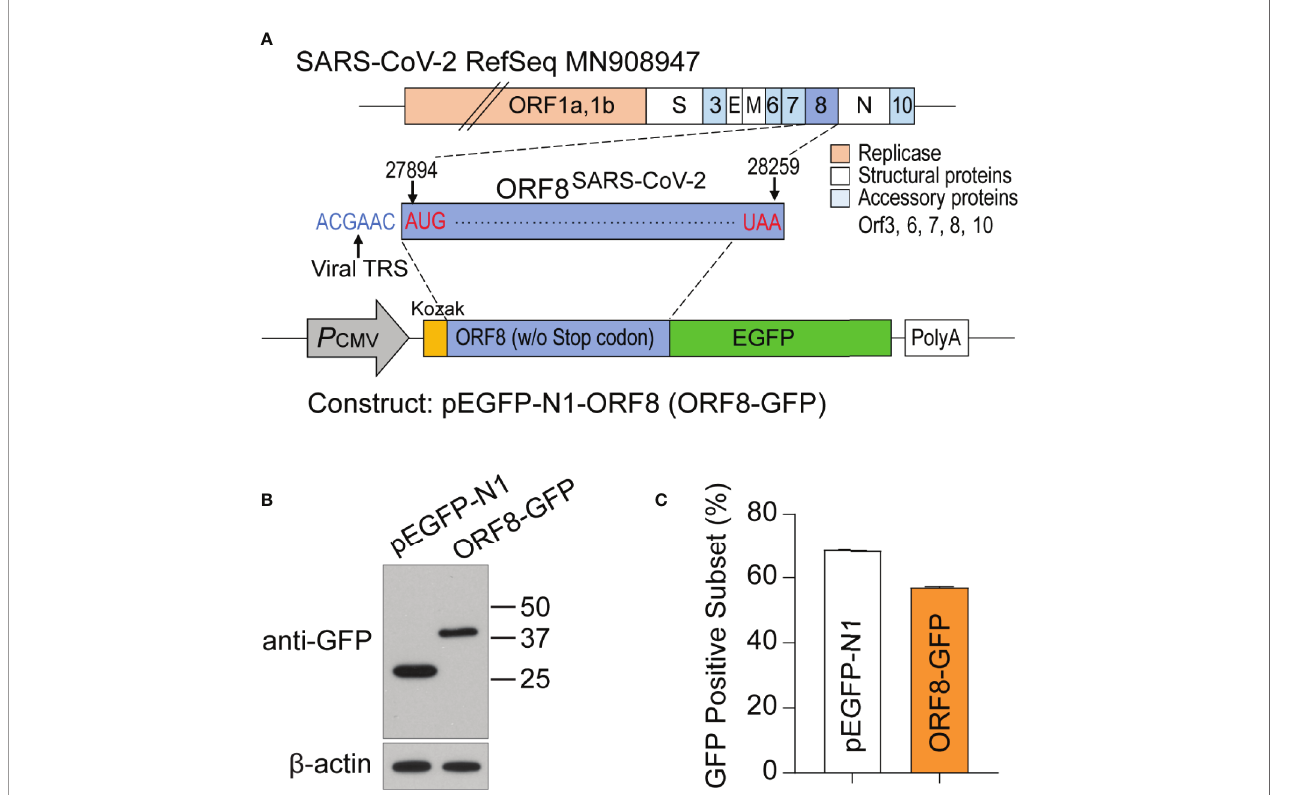
FIGURE 1 | Generating a plasmid construct to study the function of ORF8 SARS-CoV-2 in human A549 lung epithelial cells. (A) Cloning strategy to generate the pEGFP-ORF8 SARS-CoV-2 (ORF8-GFP) construct. (B) Veri fi cation of ORF8-GFP expression in A549 lung epithelial cells transfected with pEGFP-ORF8 SARS-CoV-2 by immunoblot analysis using anti-GFP antibody. Whole cell lysates were collected from cells transfected with empty vector (pEGFP-N1; EV) or ORF8-GFP at 24 hours post-transfection. (C) Characterization of the transfection ef fi ciency of ORF8-GFP in A549 lung epithelial cells using FACS analysis. Cells were subjected to fl ow cytometry 24 hours after transfection with pEGFP-N1 (EV) or ORF8-GFP. The experiments were repeated twice with triplicate